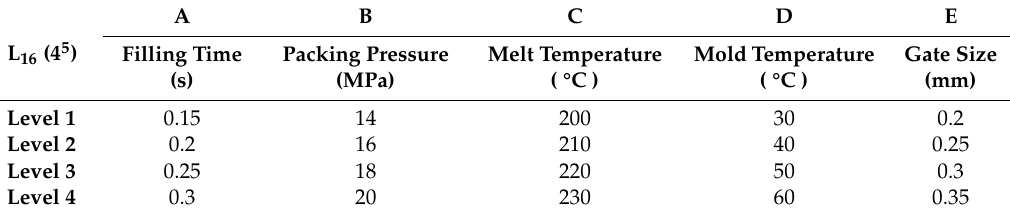
Figure 5. Simulation ( a ) model and ( b ) mesh of orthodontic brace. Table 2. Control factors and level settings used in Taguchi